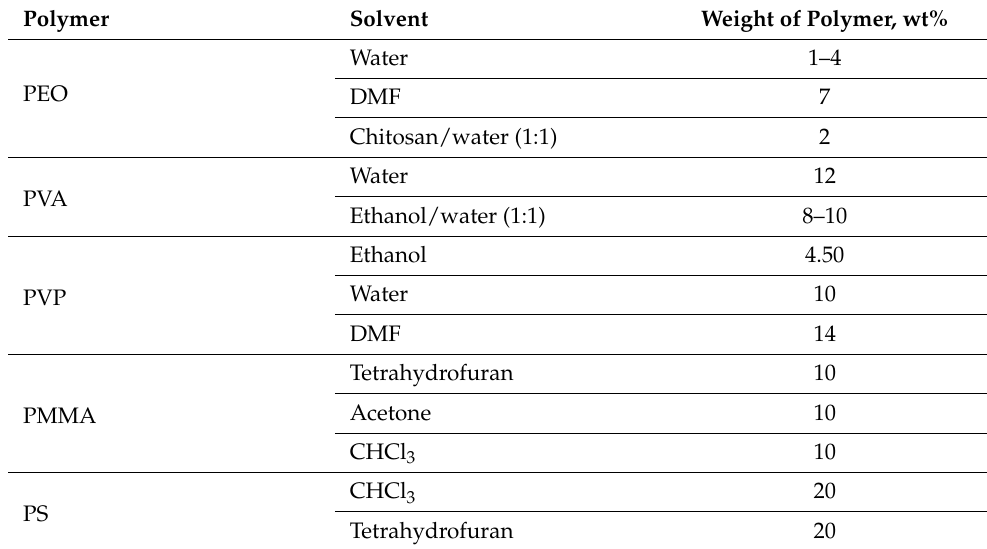
Figure 3. Different polymer fiber morphologies: ( a ) beaded; ( b ) smooth; ( c , d , f ) porous, ( e ) core-shell; ( g ) ribbon-like, and ( h ) hollow fibers. ( a , b , e , f ) Reprinted from [20]; ( c , d ) Reprinted with permission from [49]. Copyright 2018 American Chemical Society; ( g ) Reprinted with permission from [50]. Copyright 2001 Wiley-VCH; ( h ) Reprinted with permission from [51]. Copyright 2014 Royal Society of Chemistry. Table 1. Polymers and solvents commonly used for